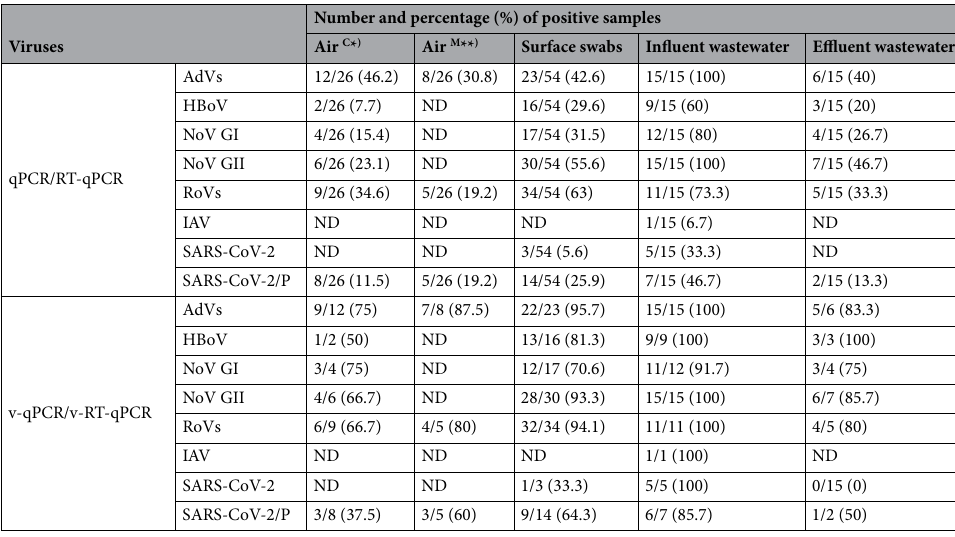
Table 2. Number and percentage of virus-positive and potentially infectious virus-positive air, surface, influent and effluent wastewater samples as identified by qPCR/RT-qPCR in total studied samples and as identified by v-qPCR/v-RT-qPCR among all positive samples. C * ) air samples collected with Coriolis μ impinger, M ** ) air samples collected with MAS-100NT impactor, AdVs adenoviruses, HBoV human bocavirus, RoVs rotaviruses, NoV GI Norwalk virus genogroup I, NoV GII Norwalk virus genogroup II, IAV influenza A virus, SARS‑CoV‑2 severe acute respiratory syndrome coronavirus 2, SARS‑CoV‑2/P presumptive SARS-CoV-2 positive/other coronaviruses positive, ND not detected.